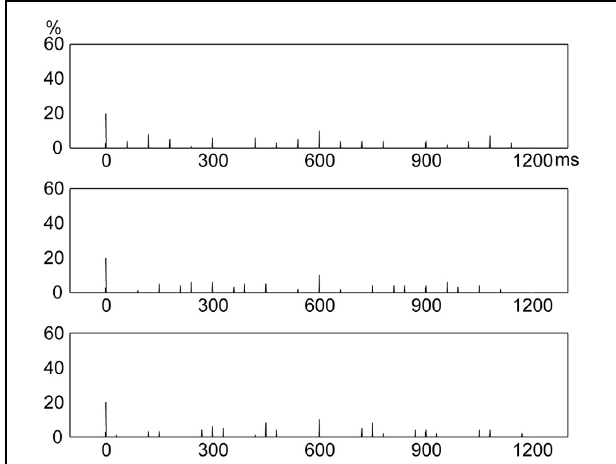
FIGURE 5 | Frequency distributions of presented events in a beat interval for three additional groups of non-integer ratios. Rhythms formed with non-integer ratios 1:1, 2.2:1, 4.4:1, and 7.4:1 (Top) ; 1:1, 2.7:1, 4.8:1, and 6.5:1 (Middle) ; and 1:1, 1.6:1, 5.5:1, and 6.9:1 (Bottom) all resulted in frequency distributions of presented events similar to that for rhythms formed with ratios 1:1, 2.3:1, 5.3:1, and 6.4:1 (see Figure 4 , bottom). Y axis: percent of event occurrences. X axis: positions with event occurrences in a beat interval 1200ms in duration.